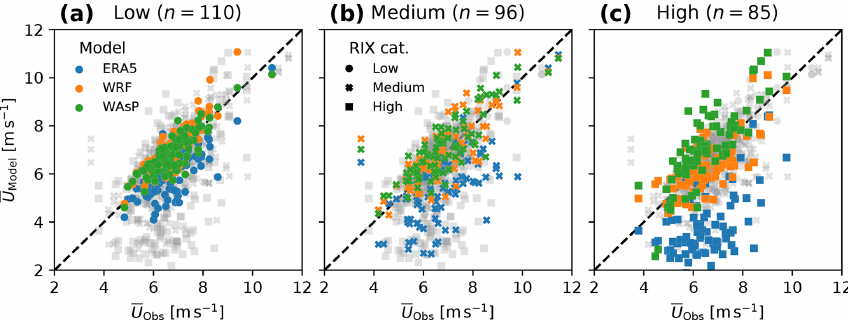
Figure 8. Observed versus modelled mean wind speed for ERA5, WRF, and WAsP. The three subplots include the same scatter points, but each of them highlight a different ruggedness index (RIX) category: low (a) , medium (b) , and high (c) . The number of masts ( n ) in each category is indicated above the